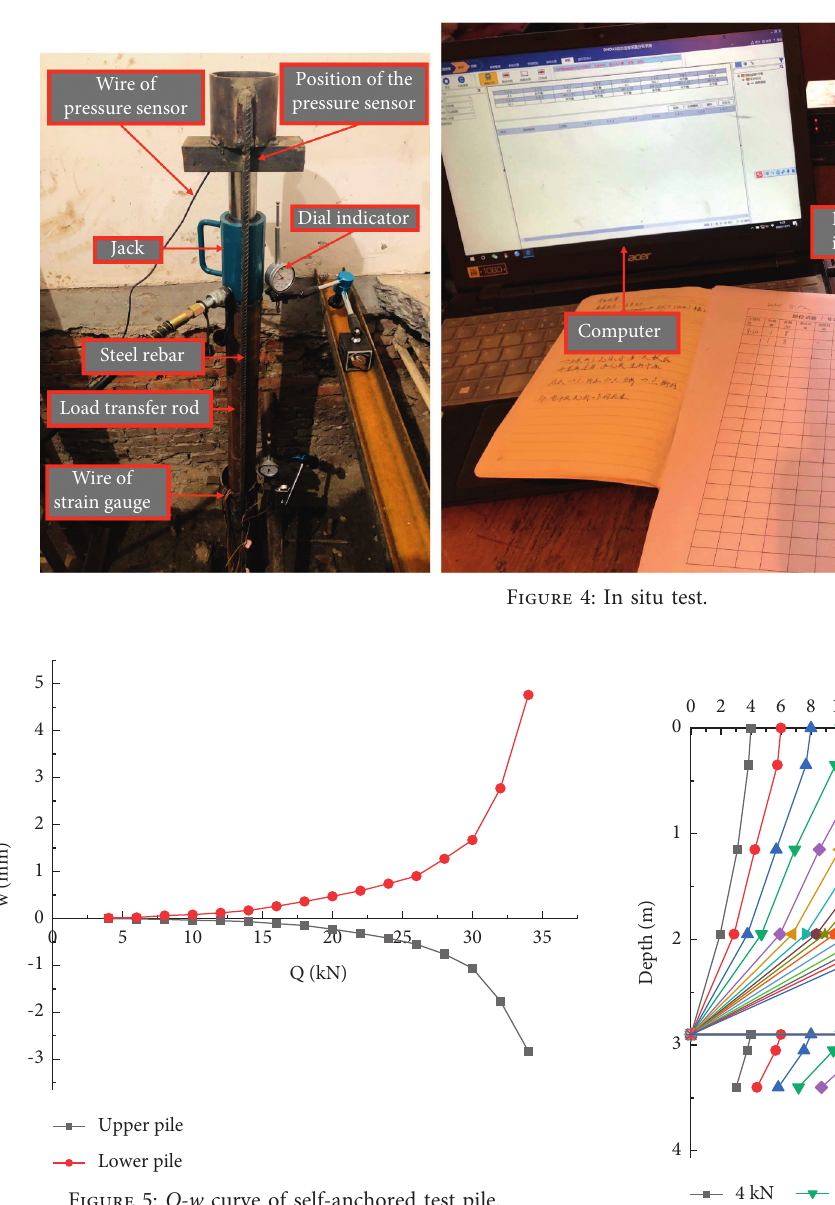
Figure 5: Q-w curve of self-anchored test pile.